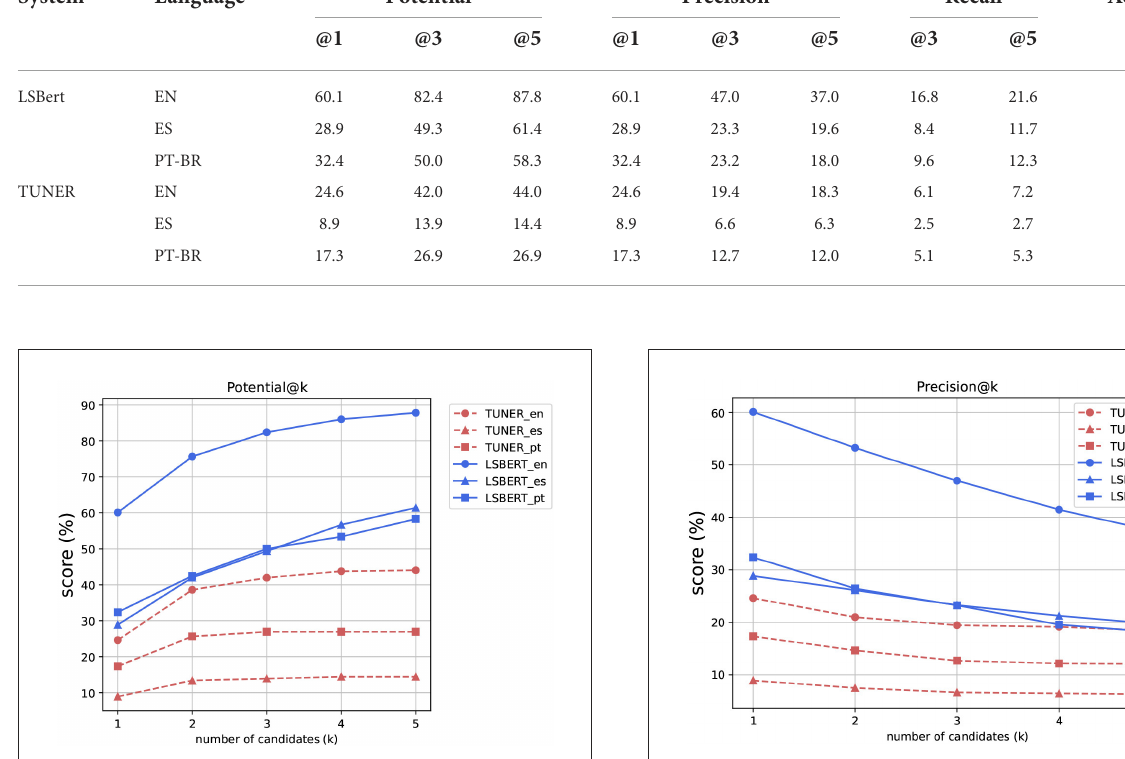
TABLE 6 Performances of TUNER and LSBert lexical simplification systems on the new dataset (note that Potential@1 and Precision@1 give the same results as per their definitions). System Language